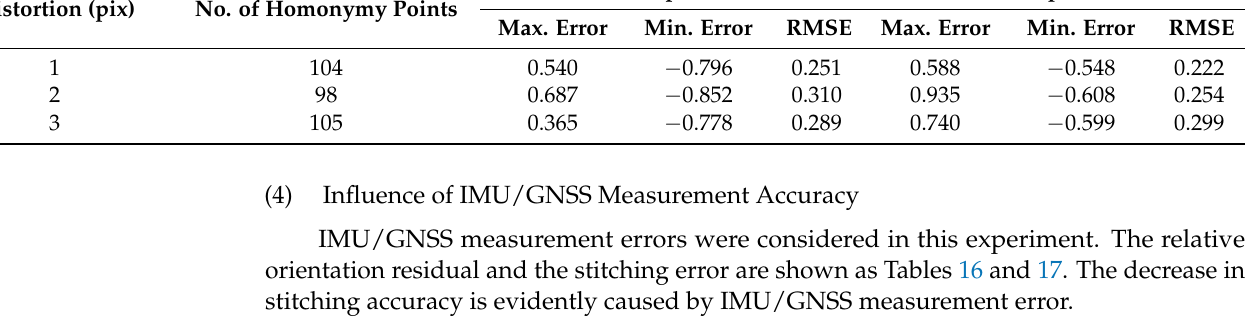
Table 16. Relative orientation residual of EA-unstable-4 (left-middle image).